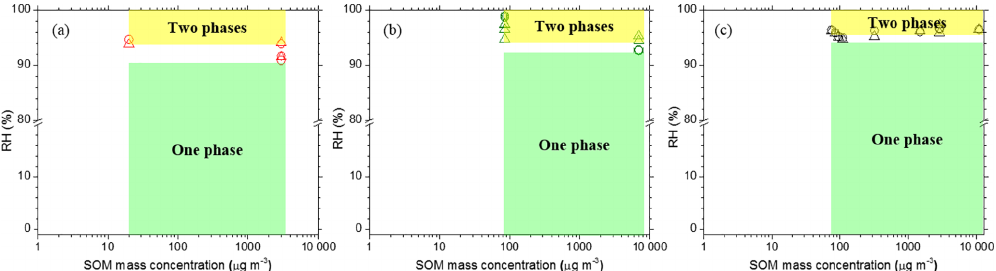
Figure 2. RH at which two phases were observed during humidity cycles of individual particles of (a) β -caryophyllene-derived SOM and (b) limonene-derived SOM from this study, and (c) α -pinene-derived SOM from Renbaum-Wolff et al. (2016) as a function of the SOM mass concentrations. For all panels, circles represent onset of phase separation upon moistening (i.e., separation relative humidity, SRH) and triangles represent mixing of two liquid phases upon drying (i.e., mixing relative humidity, MRH). Yellow shaded region indicates two phases present and green shaded region indicates one phase prevalent in SOM. SOM mass concentrations were derived from measured number–diameter distributions and assuming a material density of 1200kgm − 3 (Liu et al., 2013).